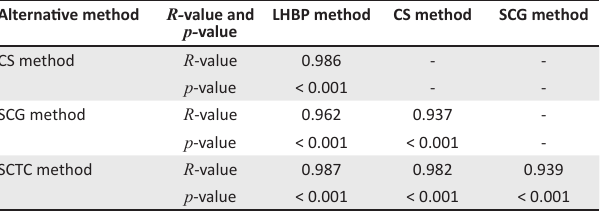
TABLE 2: Correlation between the plasma haemoglobin values determined using different methods at the Quality Control Department of the National Blood